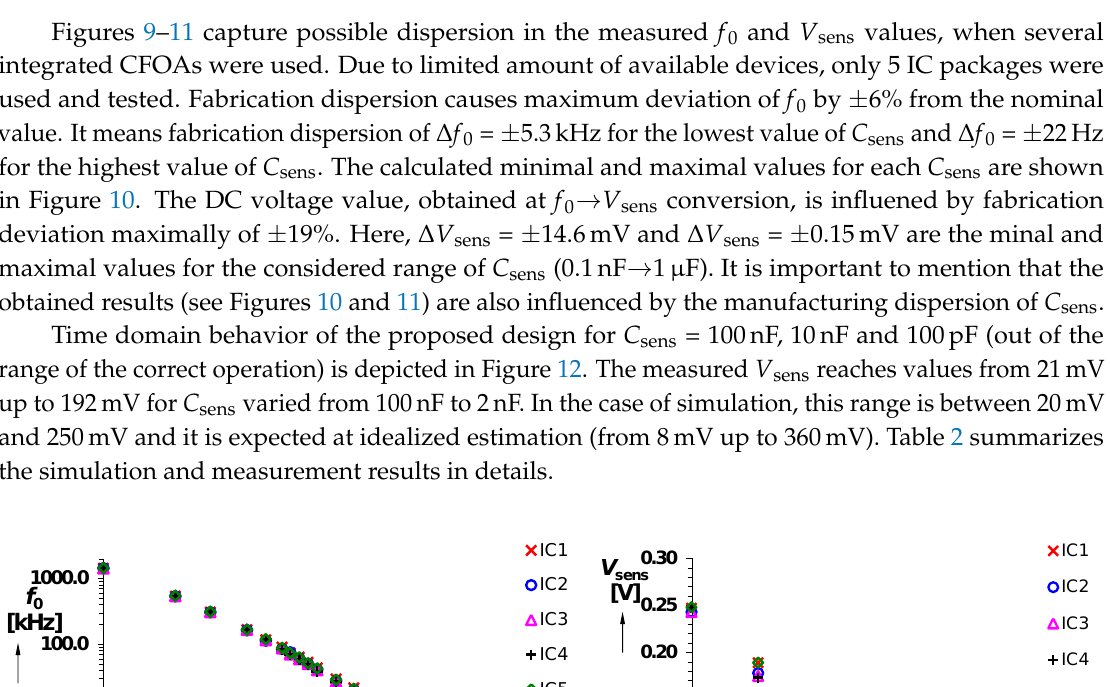
Figure 8. Difference (error) between experimental data and expectation: ( a ) f 0_error value (theory versus measurement); ( b ) V sens_error value (Mathcad simulation versus measurement).